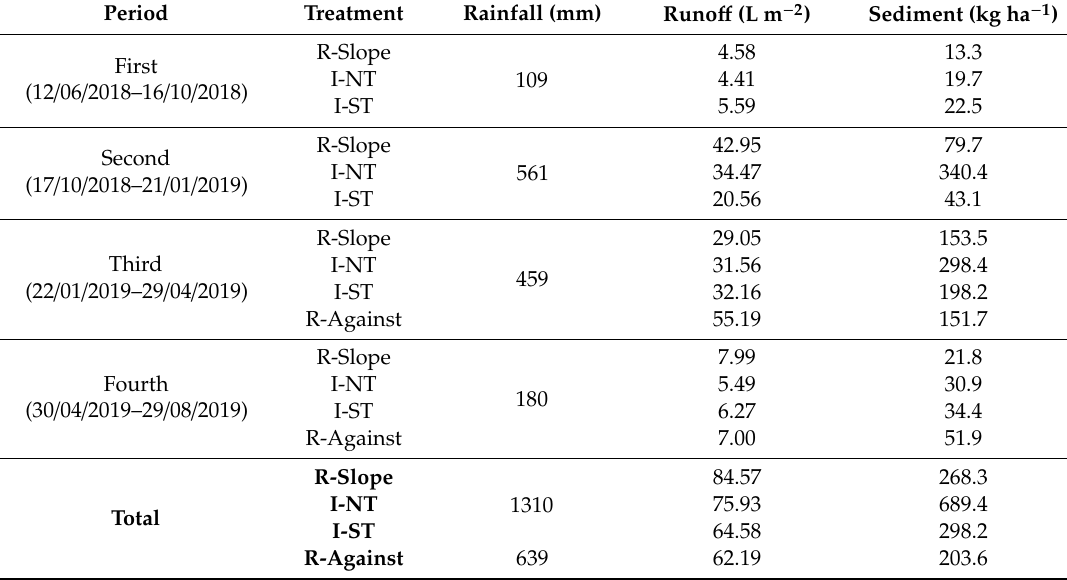
Table 2. Rainfall, runo ff and sediments mobilized by runo ff for the di ff erent treatments surveyed in the R í as Baixas vineyard from mid-June 2018 to end August